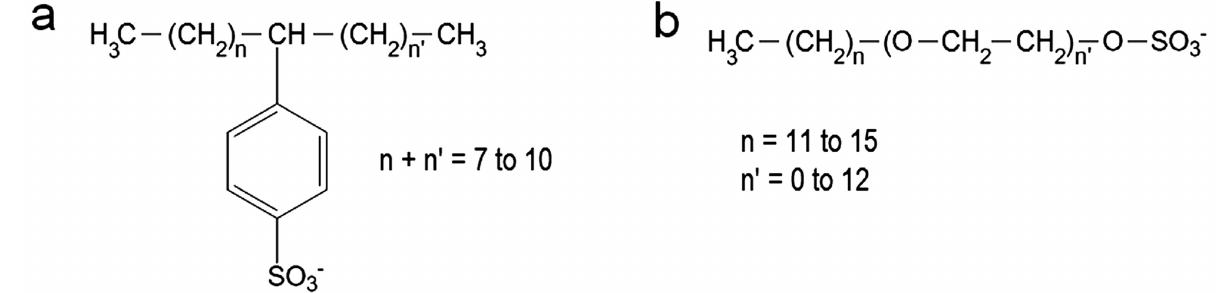
Fig . 1. – Chemical structures of a) linear alkylbenzene sulfonates (LAS) and b) alkyl ethoxysulfates